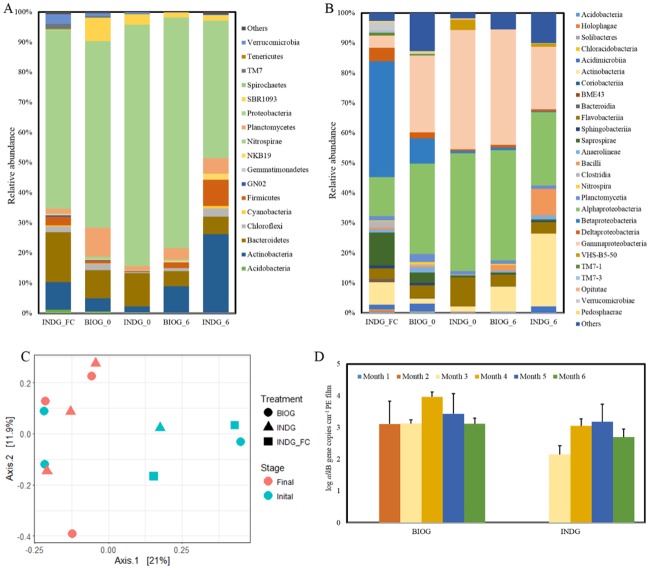
Microbial communities.Community composition of major (A) bacterial phyla and classes (B) of the biofilm communities, (C) PCoA plot of the PE adhered communities and (D) alkB gene copy numbers in biofilm communities.